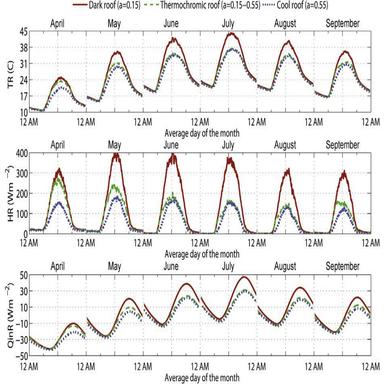
Dark (α = 0.15), thermochromic (α = − 0.15 0.55) and cool (α = 0.55) external roof surface temperature (TR), outward sensible heat flux (HR) and inward heat flux (QinR) monthly-averaged diurnal cycles for the six spring and summer months.